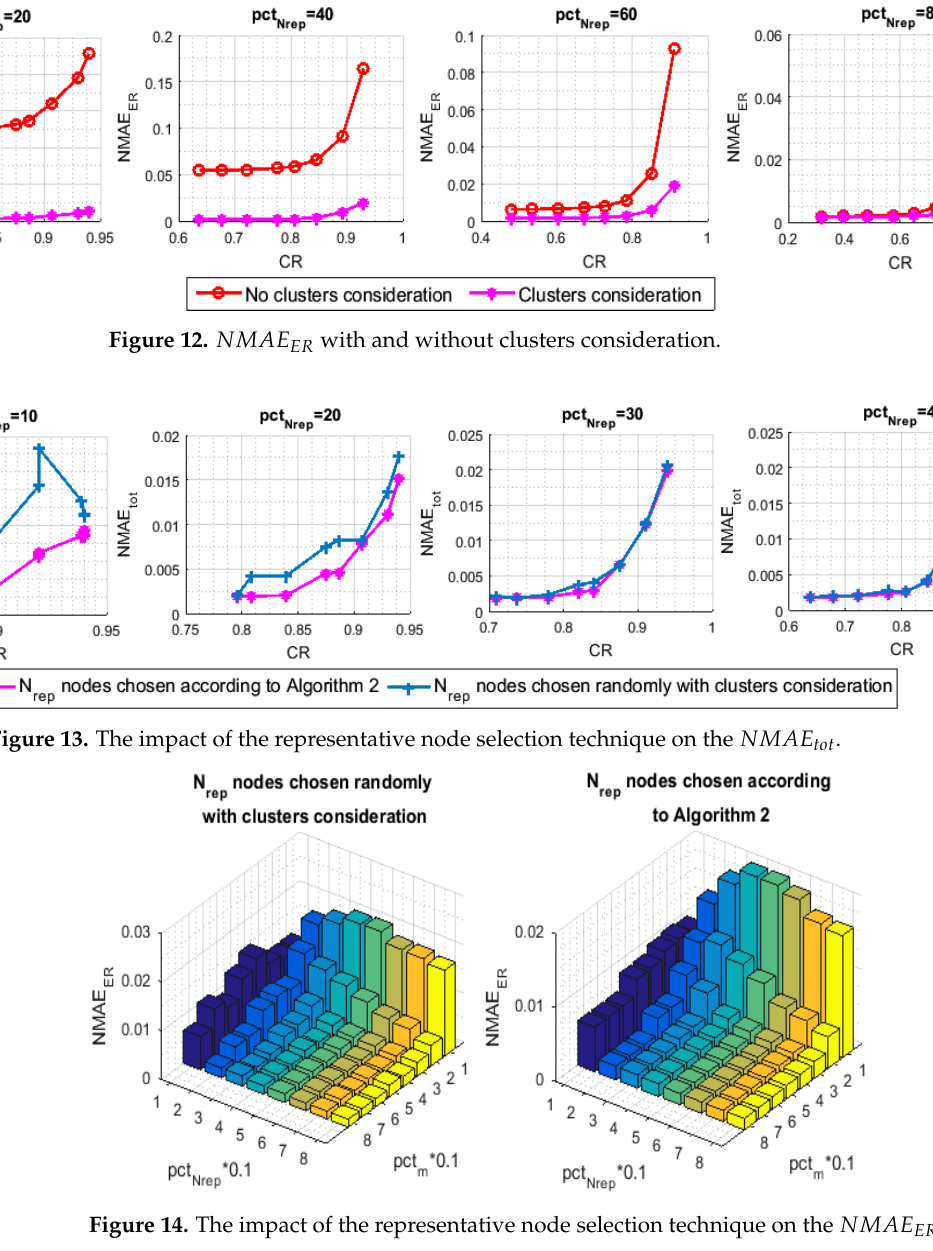
Figure 14. The impact of the representative node selection technique on the NMAE ER